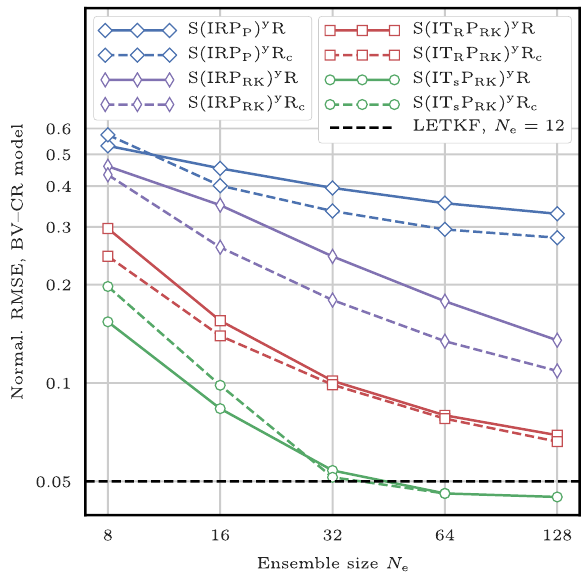
Figure 21. RMSE as a function of the ensemble size N e for the LPF y s. The scores are displayed in units of the observation standard deviation σ